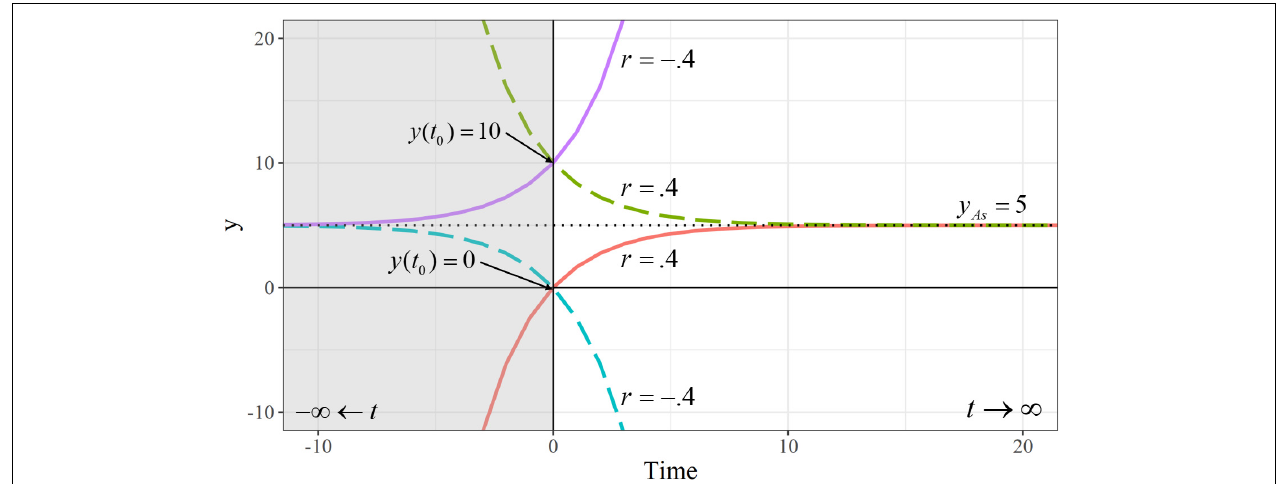
FIGURE 2 | Exponential trajectories with varying values for the initial level y ( t 0 ) and the rate of change r . Note: Negative values of time are shaded. The asymptote is represented by a horizontal dotted